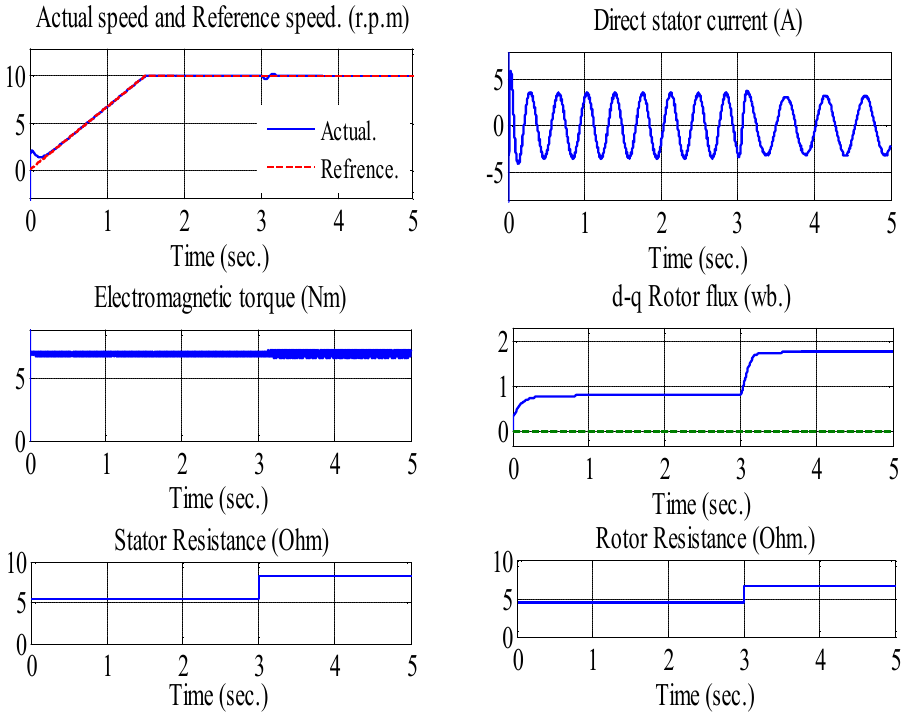
Figure 7. Performance of DFOC IM drive with stator–rotor resistance variations by 50%. Table 1. IM parameters.